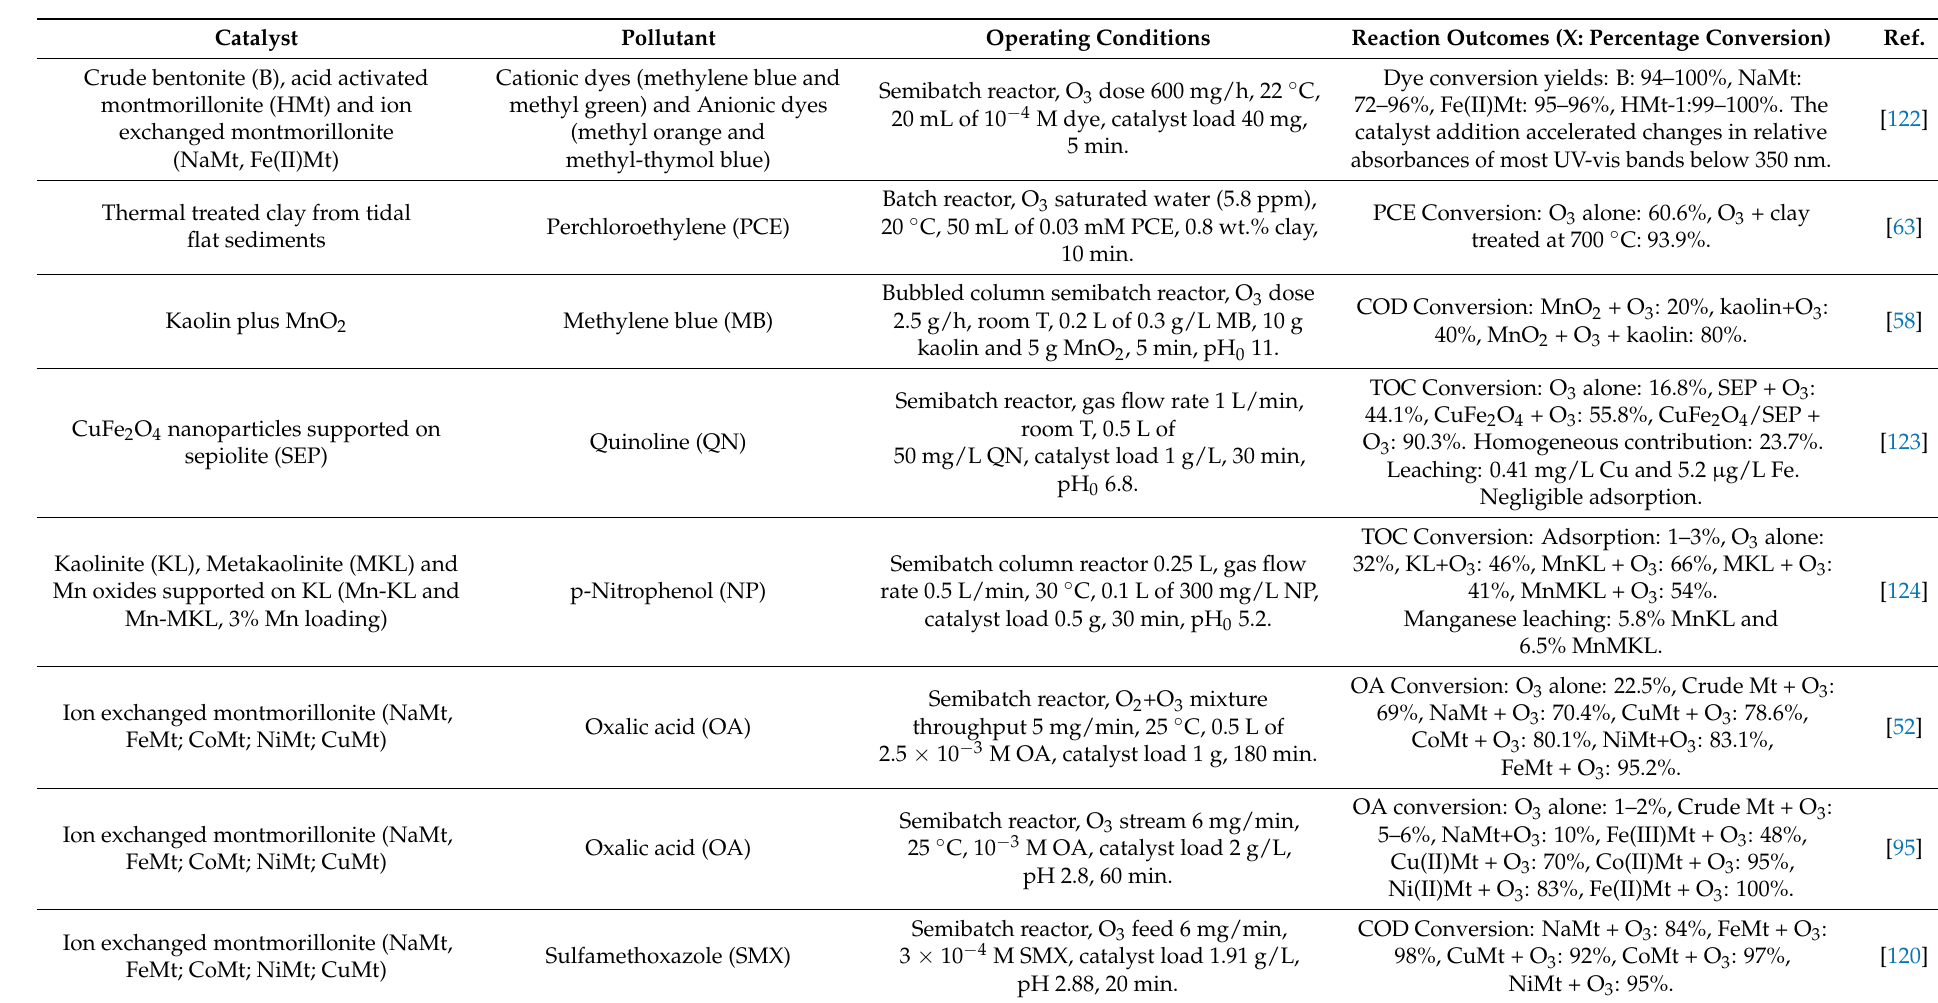
Table 1. Clay minerals as catalysts in the ozonation of organic